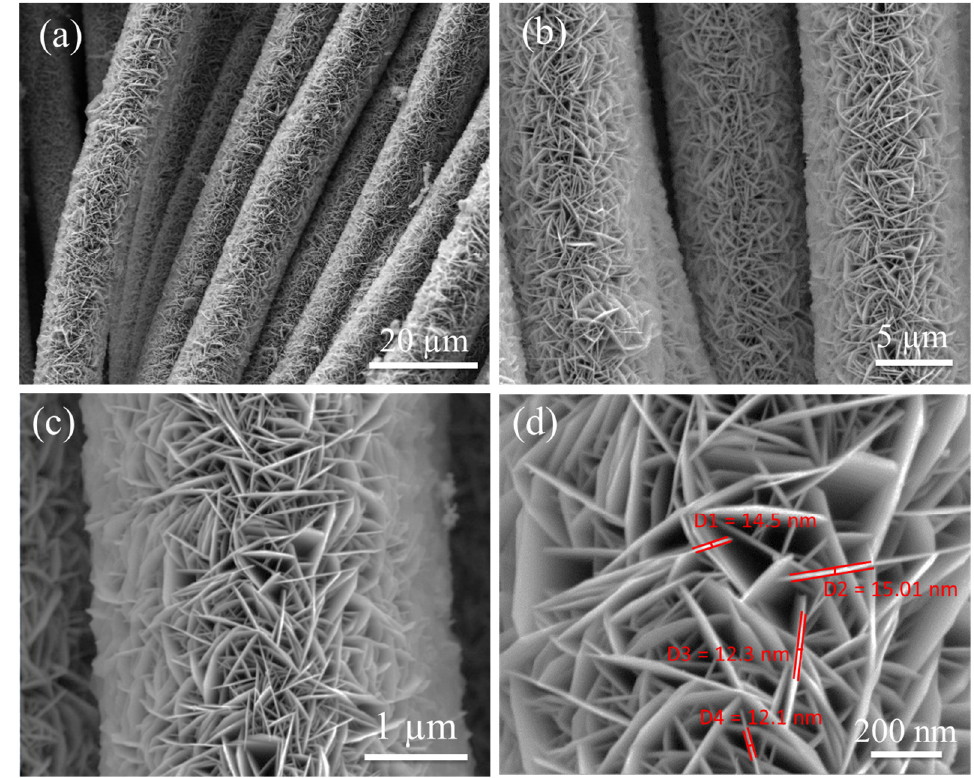
Figure 2. Representative low-resolution FESEM images: ( a , b ) vertical nature of ZnFe 2 O 4 nanoflakes at CC; ( c ) high-resolution image; ( d ) enlarged view.